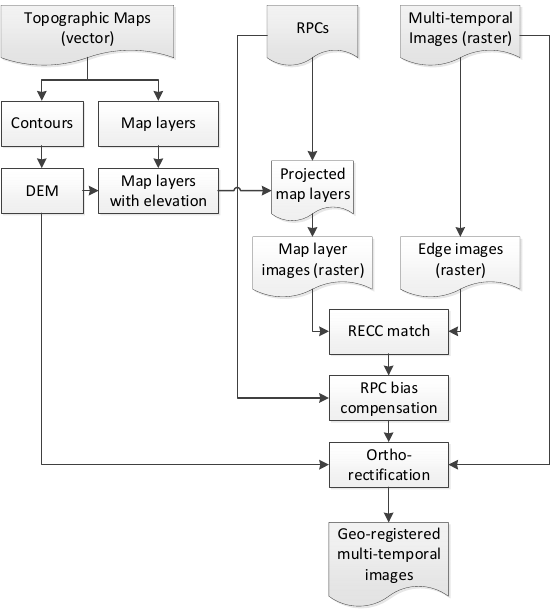
Figure 2. Detailed flowchart of global georegistration process. RECC—relative edge cross ‐ correlation.